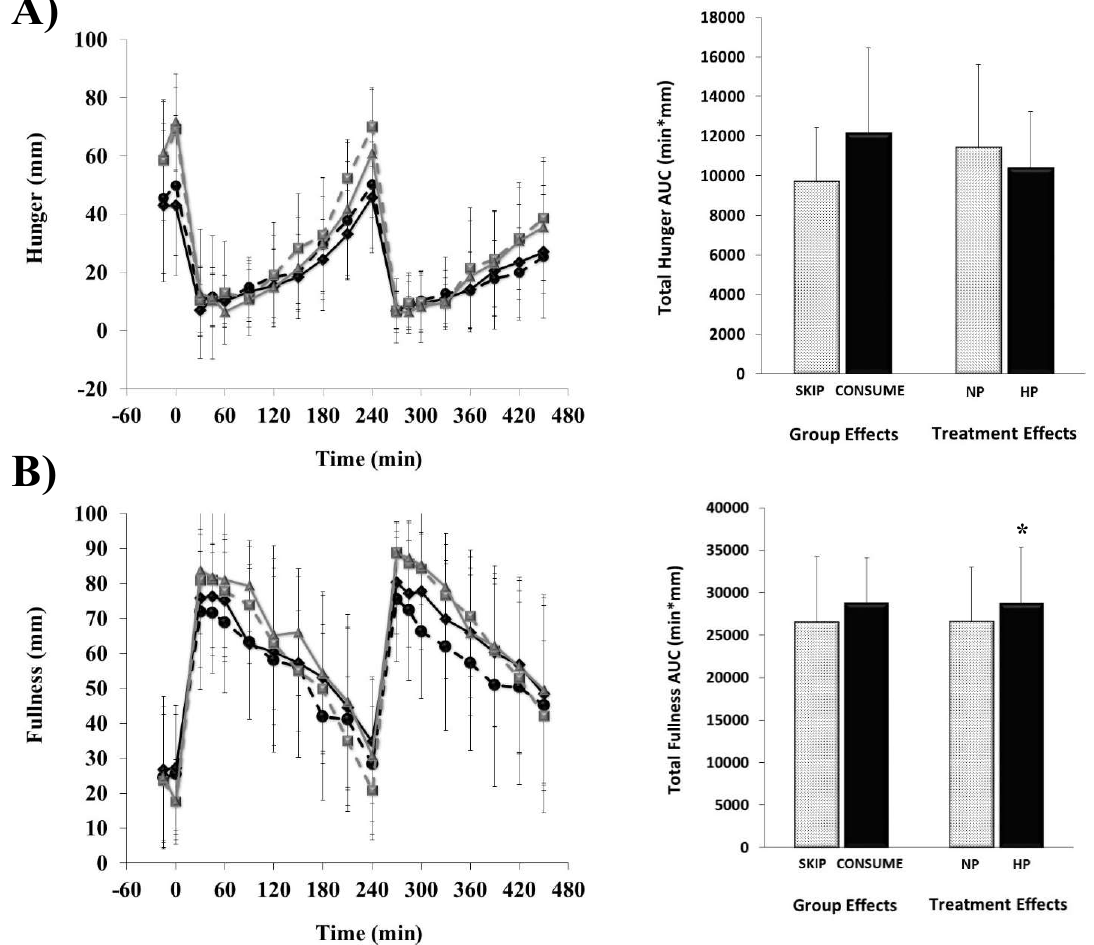
Figure 1. Perceived hunger ( A ) and fullness ( B ) responses throughout the testing days. The line graph displays the time course of change throughout the 8 h days. * denotes significance between breakfasts varying in protein quantity ( p < 0.05). Breakfast was consumed at 0 min, and lunch was consumed at 240 min. Data are means ± SD. SKIP-NP ( ), SKIP-HP ( ), CONSUME-NP ( ), CONSUME-HP ( ).